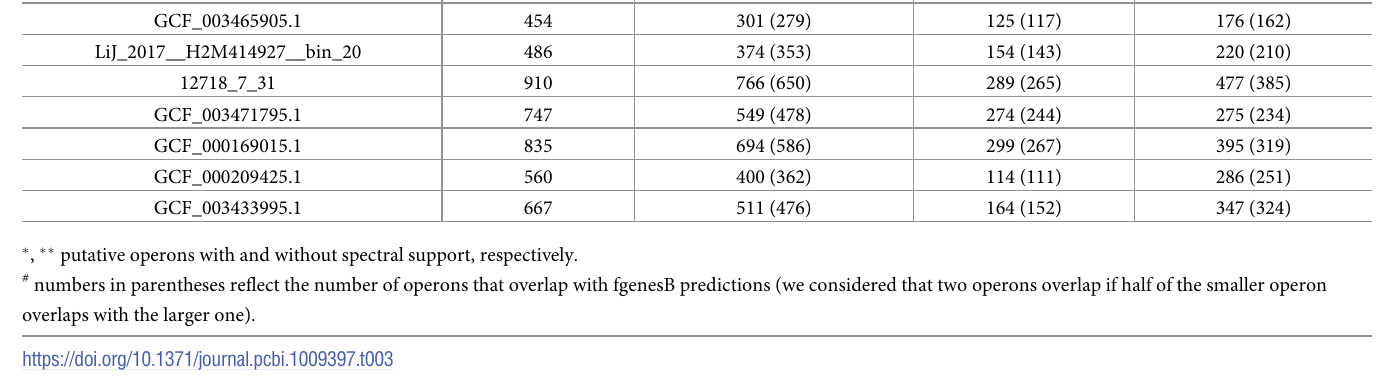
Table 3. Summary of predicted operons for the selected genomes by fgenesB and our approaches including the total with and without spectra support. genome id